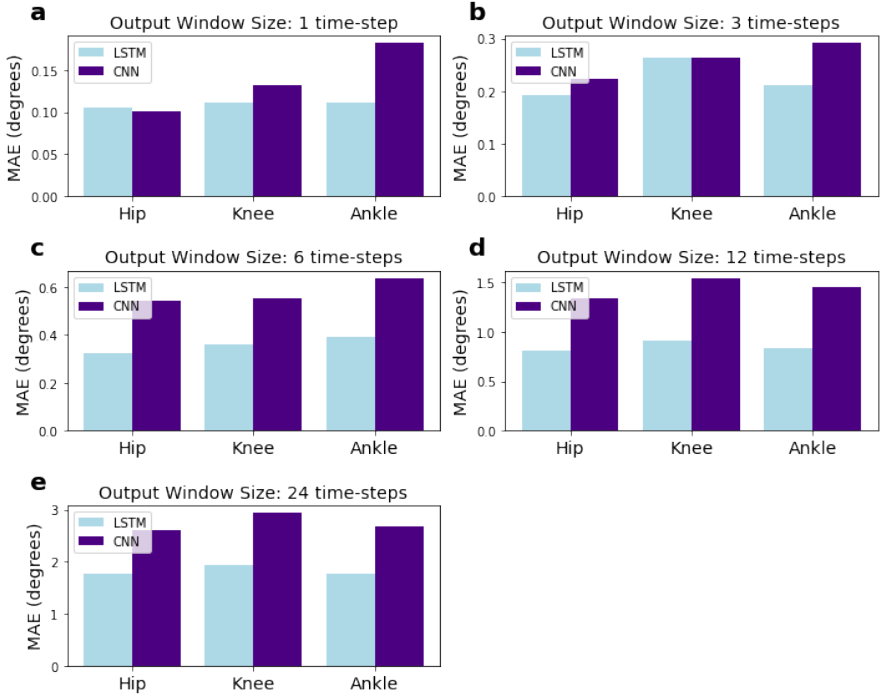
Figure 8. MAEs for each of the hip, knee, and ankle joints for the CNN and LSTM network with varying output sizes. Input window size is fixed at 120 time-steps and the MAE for each joint represents the combined MAE for the yaw, pitch, and roll dimensions. Sub-figures ( a – e ) correspond to networks with 1, 3, 6, 12, and 24 output time-steps,